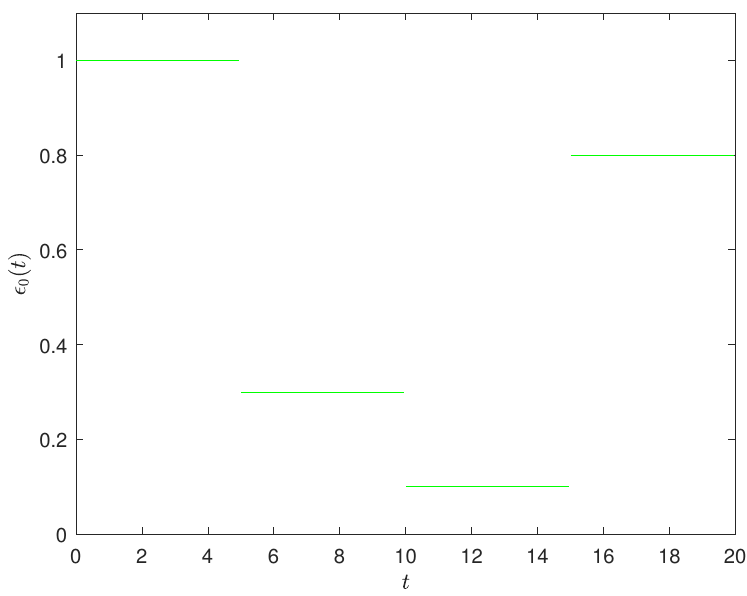
Figure 7. Parameter (cid:101) 0 ( t ) was set as a piecewise function in the improved event-triggered scheme in Example 1. In multiple time periods, triggering parameter (cid:101) 0 ( t ) took different